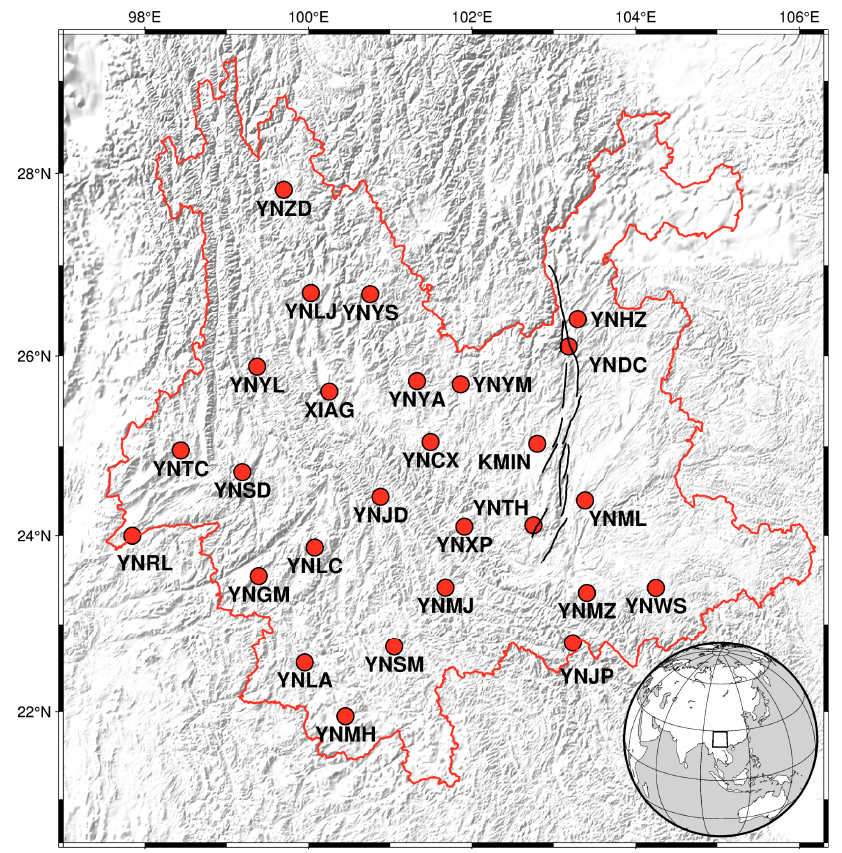
Figure 1. The location distribution of 27 GPS stations in Yunnan represented by red dots. The red line represents the boundary of Yunnan. The black line represents the Xiaojiang Fault.